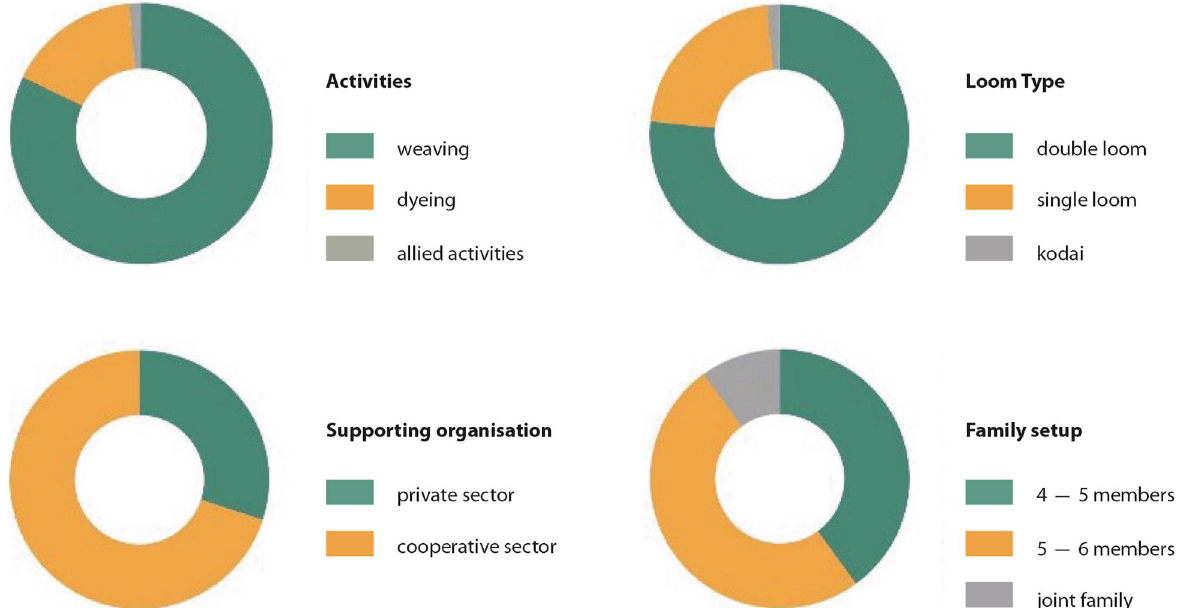
Fig. 10 Activities, loom types, supporting organisation and family setup within the cluster (Source: the author)